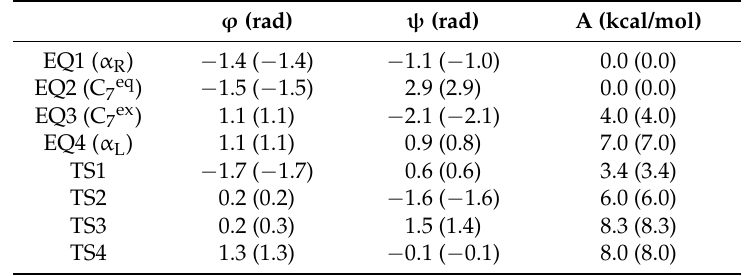
Table 1. The characteristics of all equilibrium conformations (EQ) and transition states (TS) calculated with our scheme (N = 132). The values obtained from usual US + WHAM calculations are also listed in parentheses.